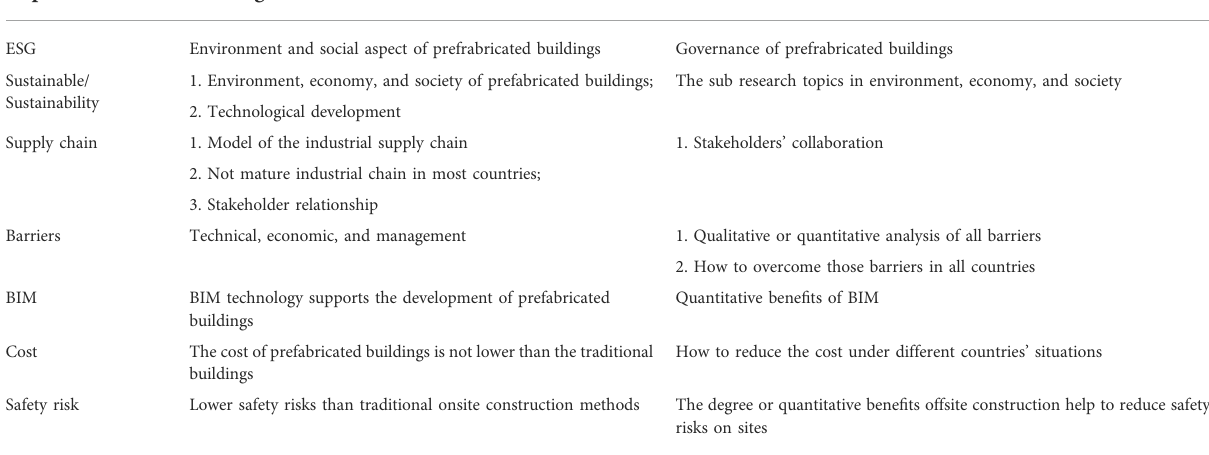
TABLE 8 Existing research and need for future